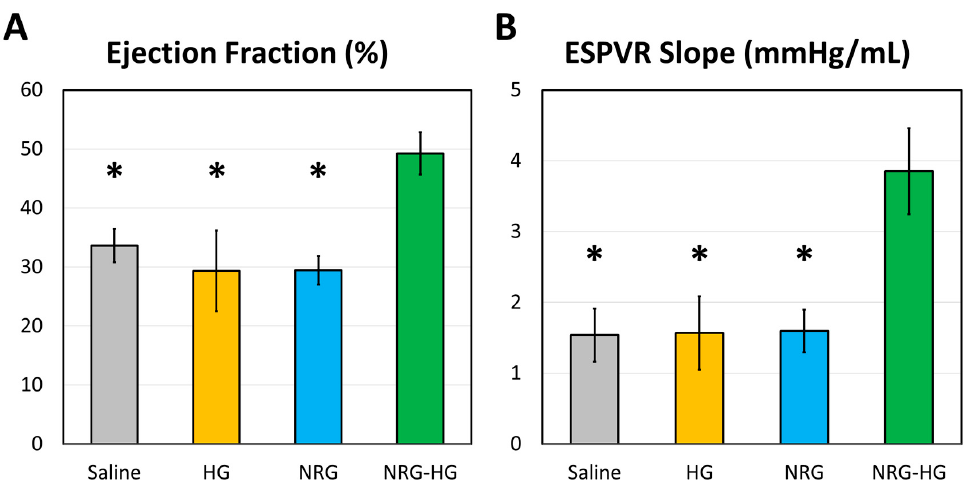
Figure 2. Cardiac function at 8 weeks after myocardial infarction, measured by analyzing closed-chest left ventricular pressure-volume hemodynamics data. Data regarding ( A ) ejection fraction (%) and ( B ) the slope of the end-systolic pressure–volume relationship (ESPVR, mmHg/mL) are compared among sheep receiving saline ( n = 6), hydrogel only (HG, n = 4), neuregulin only (NRG, n = 4), and hydrogel-encapsulated neuregulin (NRG-HG, n = 6). Data are presented as mean ± standard error. * indicates statistically significant ( p < 0.05) compared to the NRG-HG group.